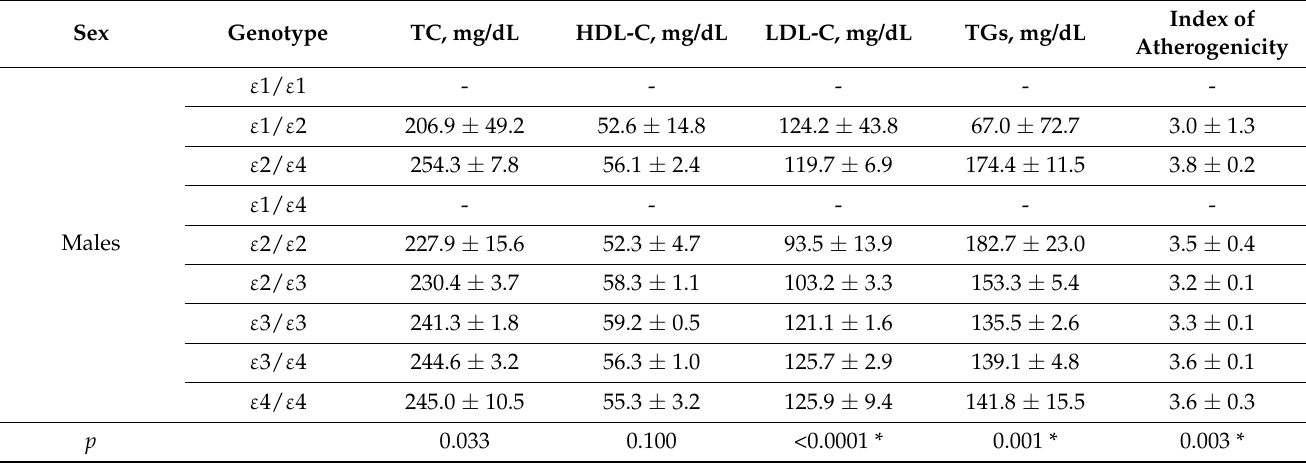
Table 4. Associations of rs429358 & rs7412 genotypes with parameters of the blood lipid profile in the mostly white population of Western Siberia ( n =